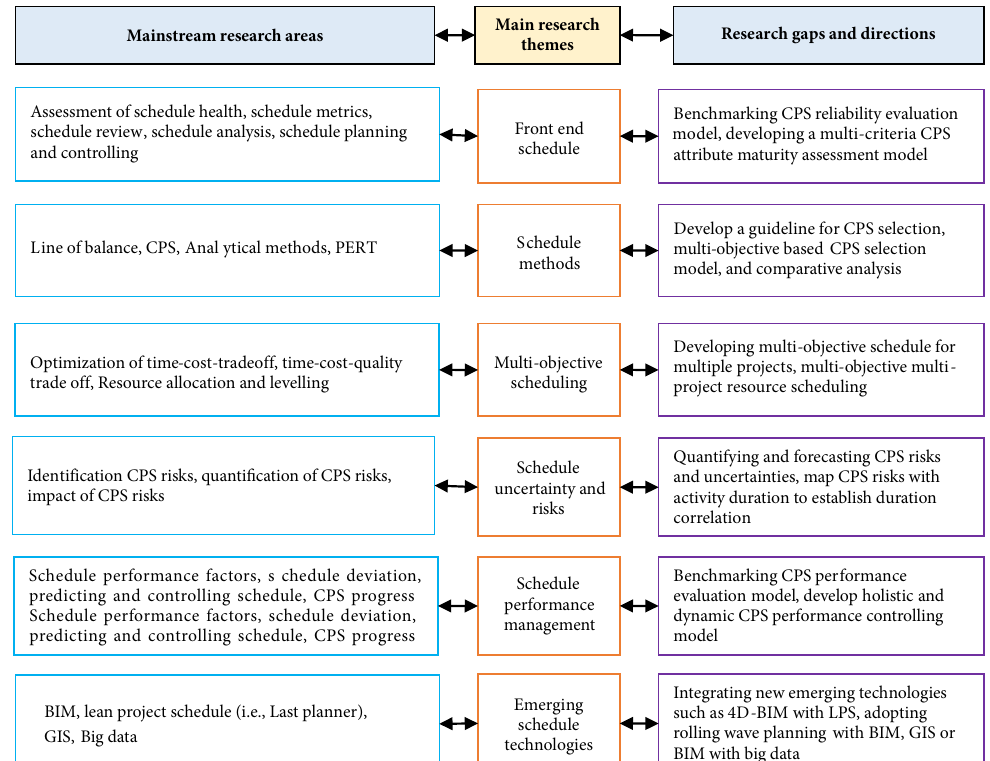
Figure 8. Comprehensive proposed frame work for CPS: Research areas and